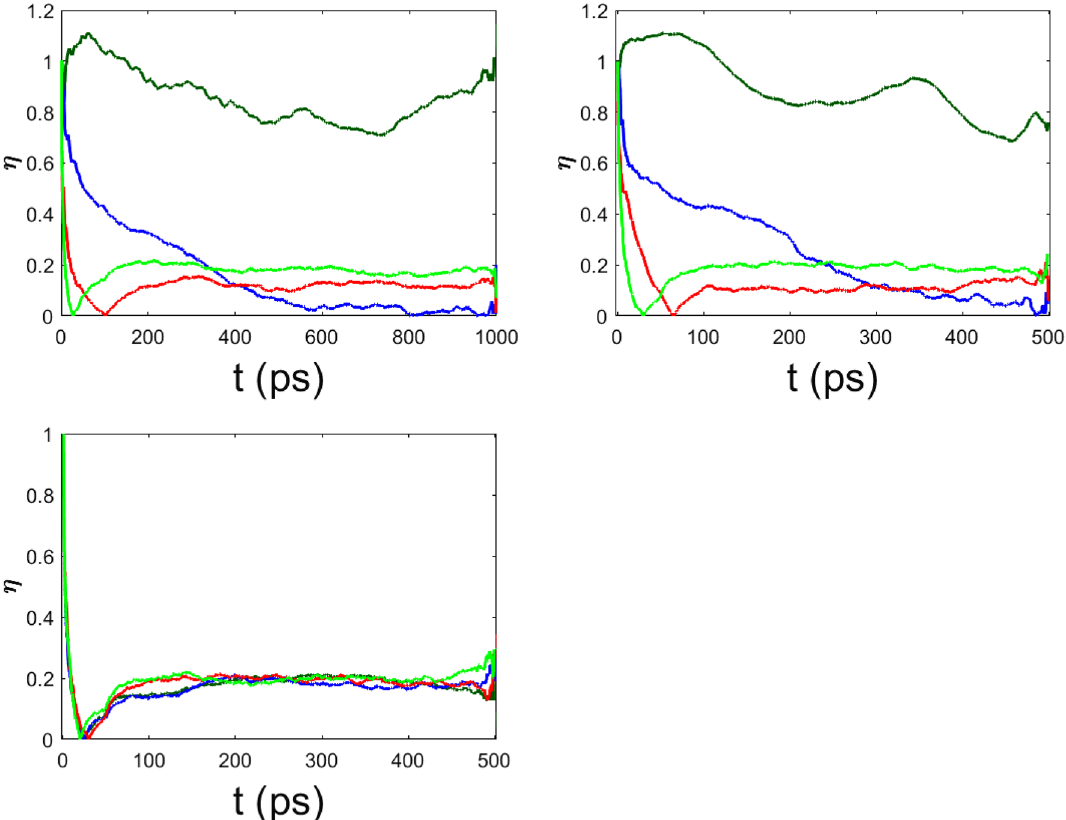
Figure 9. The spectral entropy η is plotted vs time for different values of χ ′ . Upper left panel : χ ′ 0 (dark green), µ 0.1 (dark blue), µ pN) and µ ′ ′ = = 4 ( χ 488 pN), µ 0 (dark green), µ χ ′ ′ = = = 4 ( χ 488 pN), µ 0.1 and ǫ panel: χ ′ ′ = = =